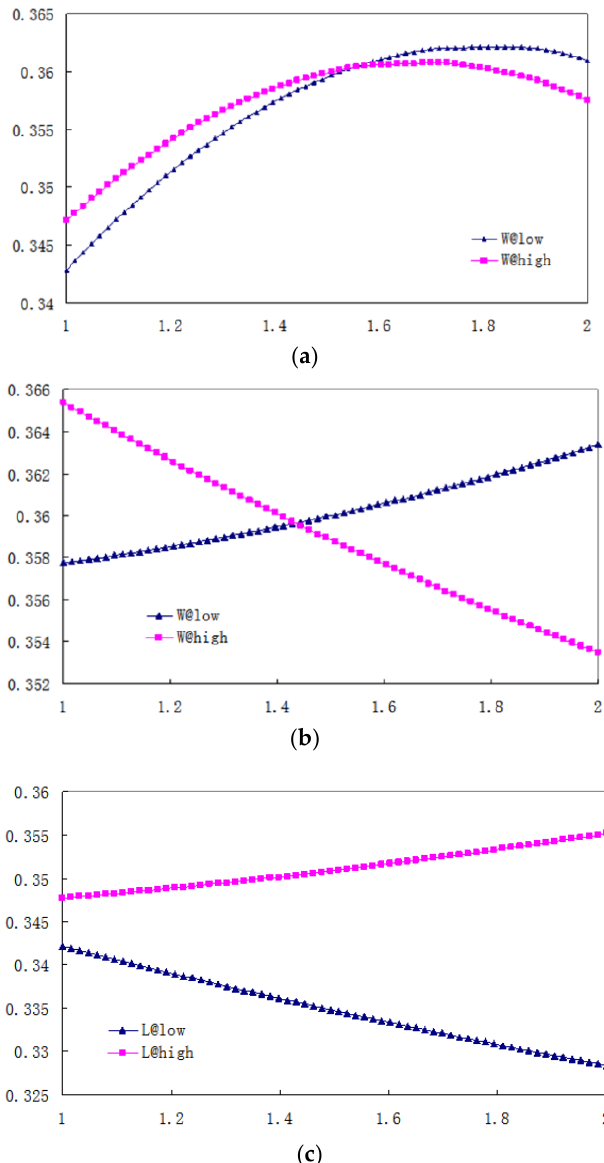
Figure 9. Interaction effect between design variables (unit of axis labels: mm): ( a ) Interaction of L with W on C d . ( b ) Interaction of D with W on C d . ( c ) Interaction of D with L on C d .